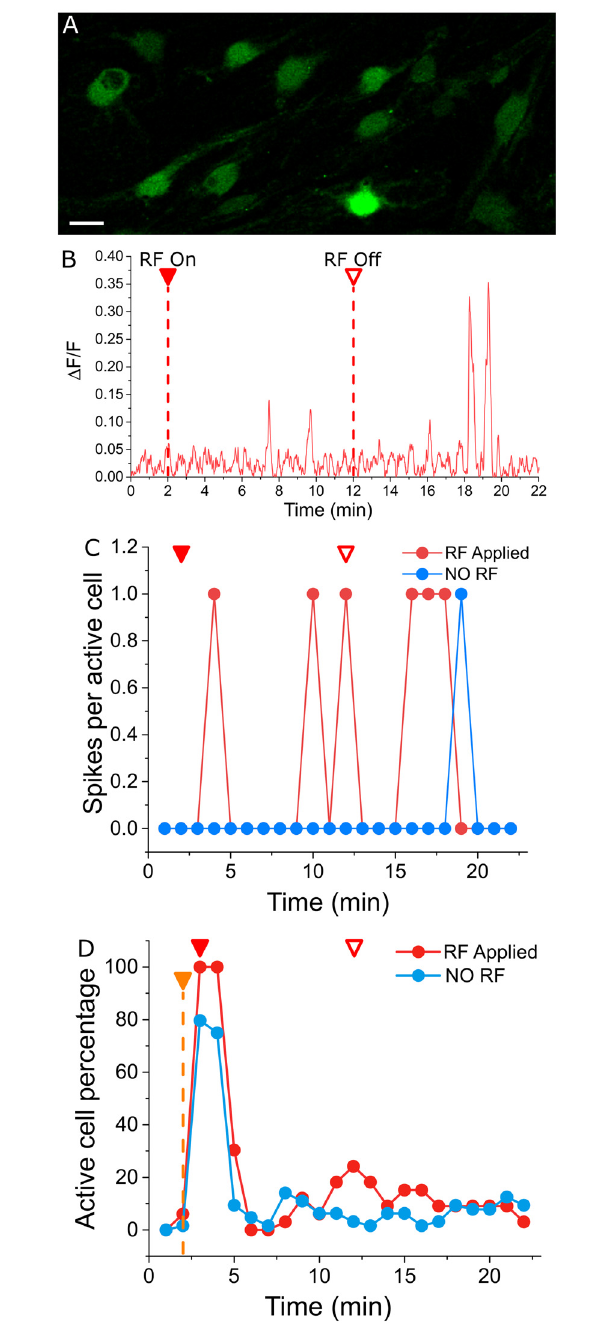
Fig 5. Effects of RF EMF on the spontaneous spiking activity of dissociated DRG sensory neurons in the absence and presence of inflammatory cytokine, TNF- α . (A) Representative confocal image of dissociated DRG neurons following 15 min incubation with 5 μ M Fluo-3 AM (Scale bar = 15 μ m). (B) Unsmoothed Δ F/F for a single cell. Spikes correlate to an increase in intracellular calcium concentration. (C) Spikes per active cell calculated at 0.35 for RF EMF ‘ OFF ’ (n = 163) or ‘ ON ’ (n = 232). Spikes persisted after removal of the RF stimulus, which was consistent with observations from behavioral assays. (D) A larger percentage of DRG neurons were active when RF EMF stimulus was applied to cultures perfused with inflammatory cytokine TNF- α (10